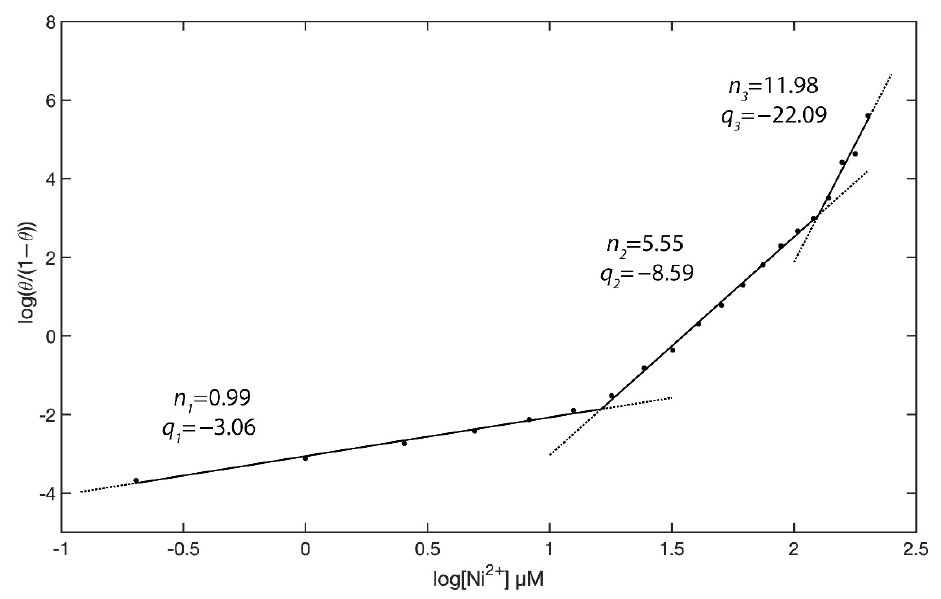
Figure 13. Hill plot for at AgNPs@11MUA binding to increasing concentrations of Ni 2+ . Local linear fits to Equation (3) are displayed as solid lines.